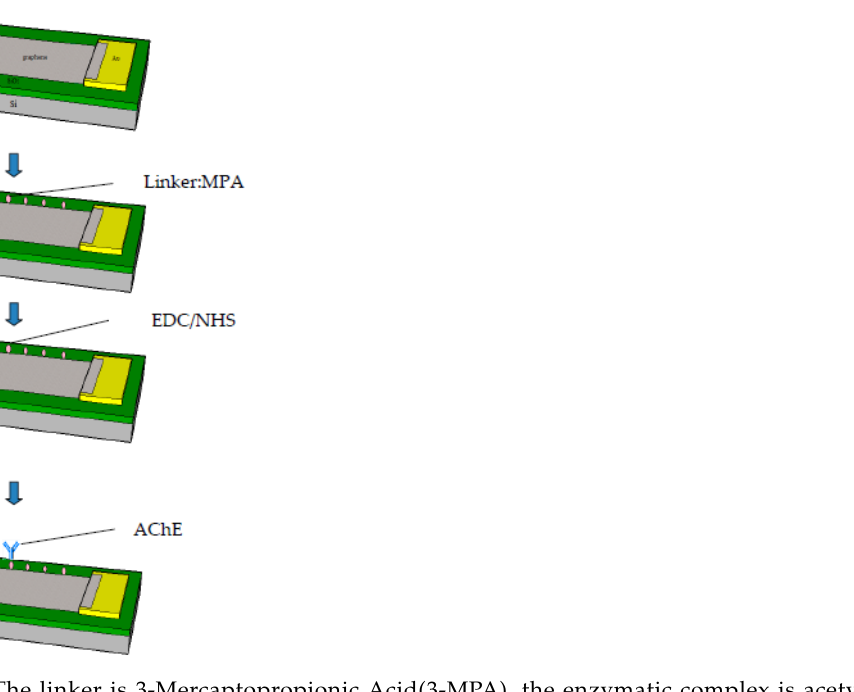
Figure 3. The linker is 3-Mercaptopropionic Acid(3-MPA), the enzymatic complex is acetylcholinesterase (AChE).